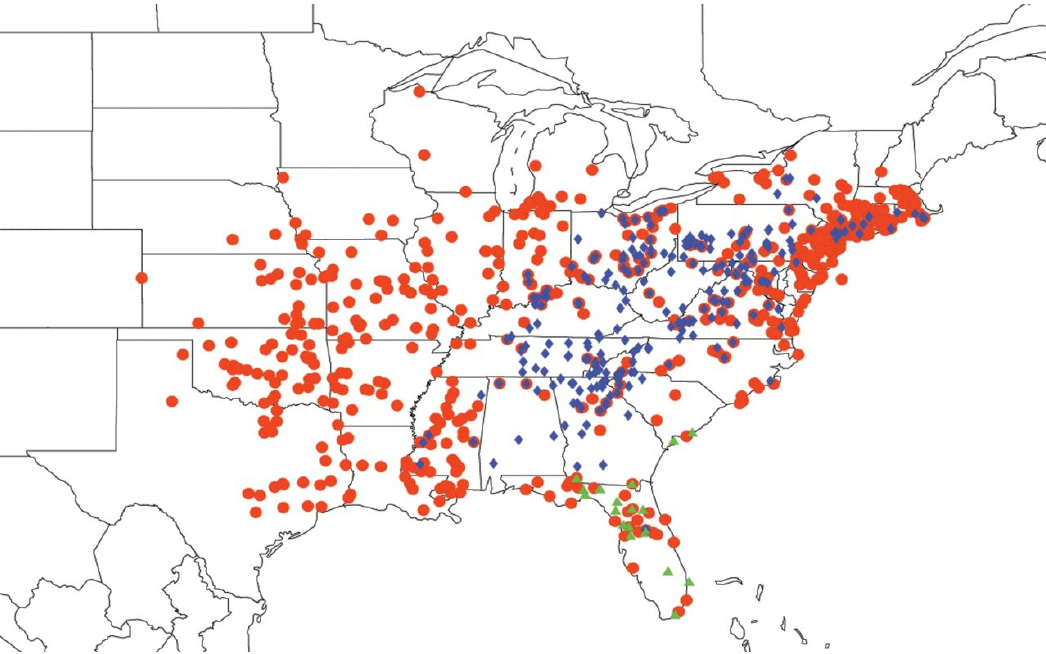
Figure 11. Distribution of Tibicen lyricen lyricen (orange circles), T. lyricen engelhardti (blue diamonds) and T. lyricen virescens (green